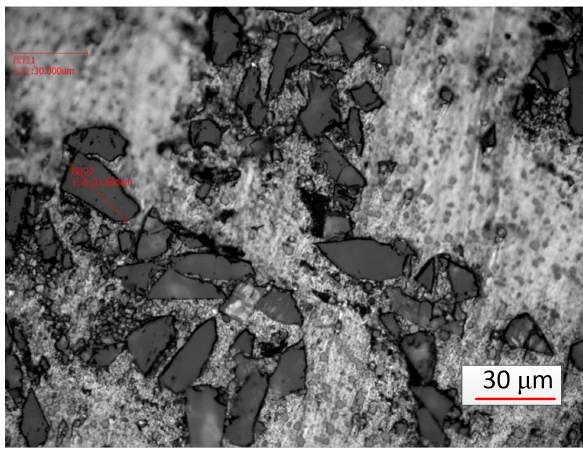
Figure 1: SEM micrograph of the